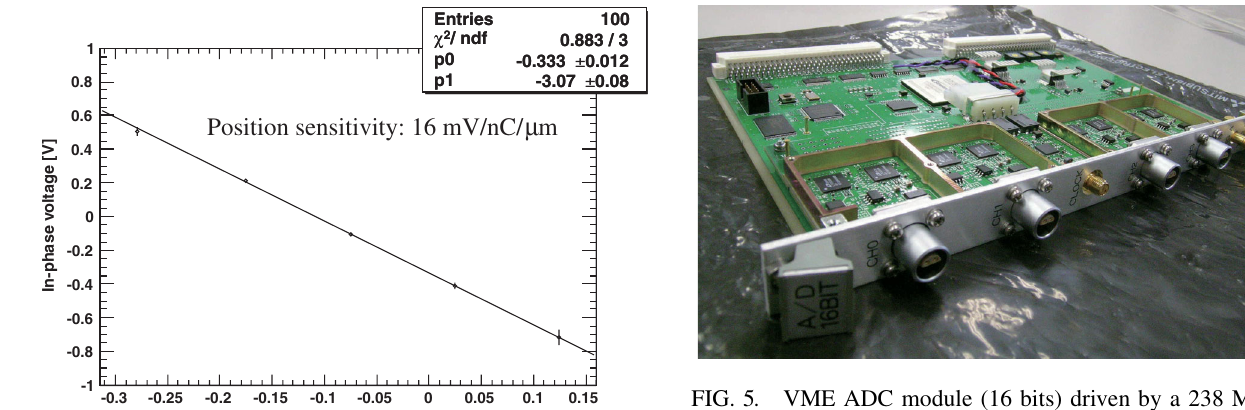
FIG. 5. VME ADC module (16 bits) driven by a 238 MHz rf